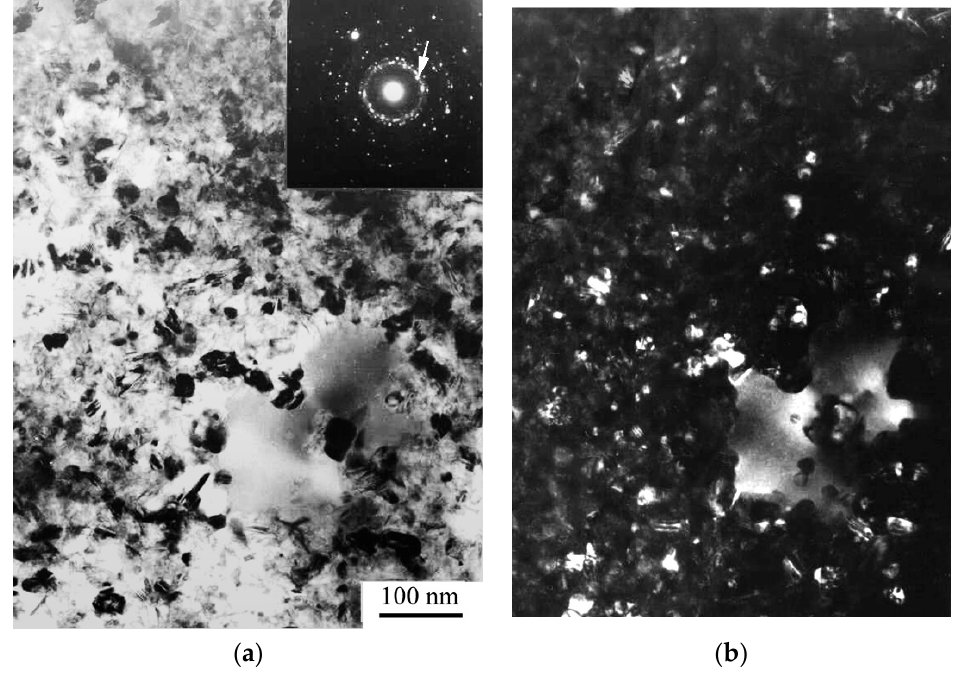
Figure 3. Decomposition of the nanocrystalline phase in (Ni65Mo35)90B10 alloy (873 K, 240 h; ( a ) bright ‐ field and ( b ) dark ‐ field images are in the reflection shown in the electron diffraction pattern).